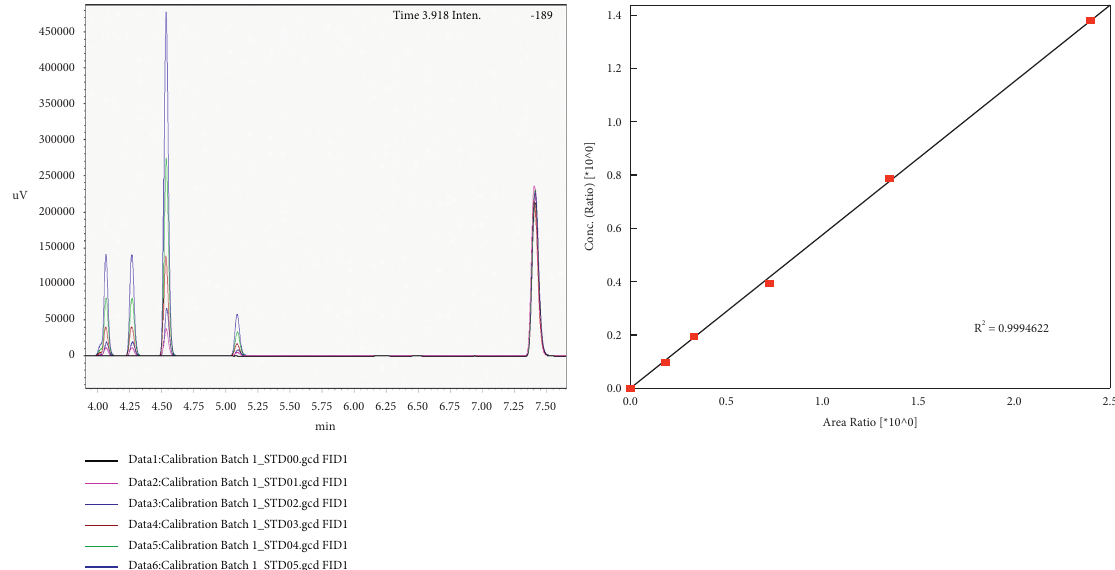
Figure 2: Chromatogram and group-calibration curve of standards (0–938mg kg − 1